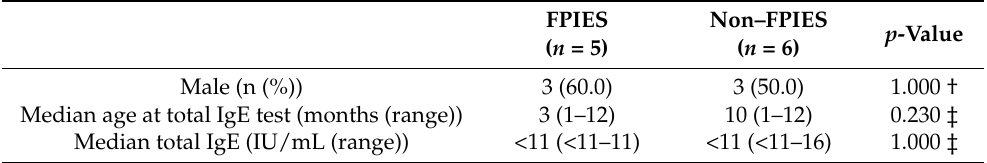
Table 3. Serum total IgE level in children with